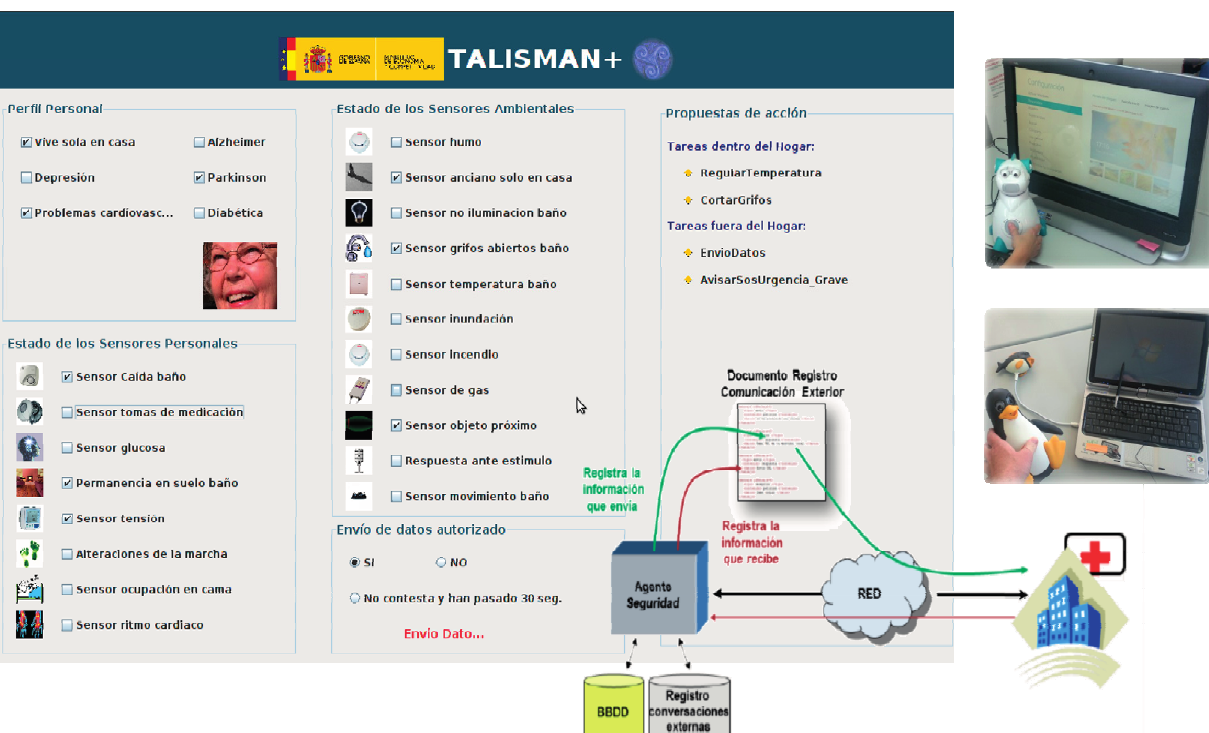
Figure 9. TALISMAN+ security supporting local reasoning